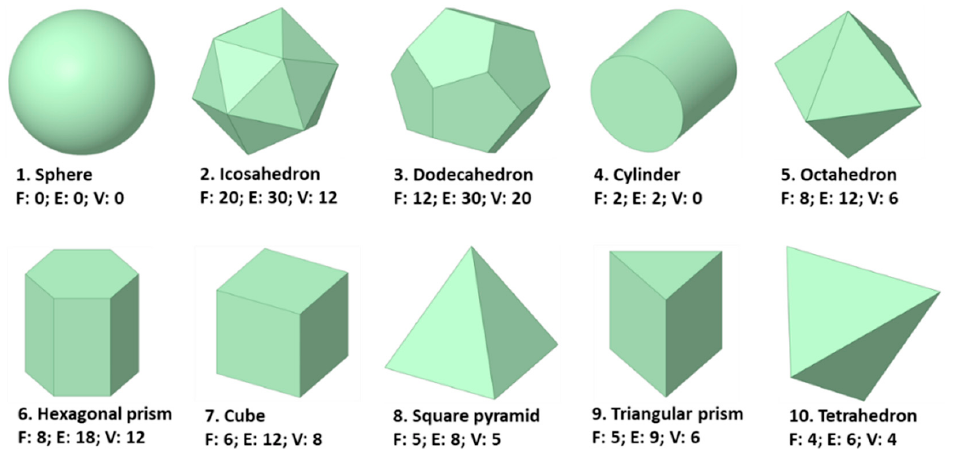
Figure 1. 3D particle shapes considered in this work with shape properties. Table 1. Overview of sphericity and surface area of all particles together with assigned particle ID ( A p in mm 2